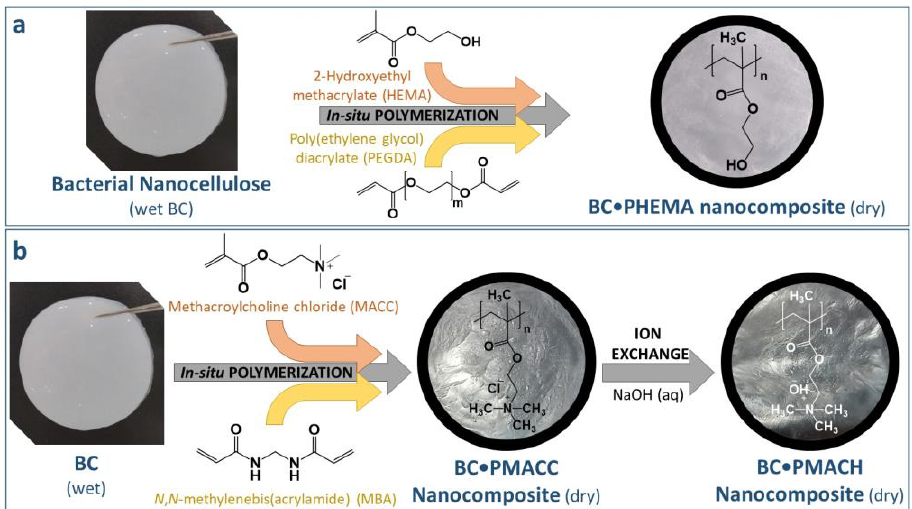
Figure 1. Scheme of the preparation of the bacterial nanocellulose (BC)-based nanocomposites containing neutral ( a ) and ionic ( b ) moieties (evidencing the position of the methyl groups).